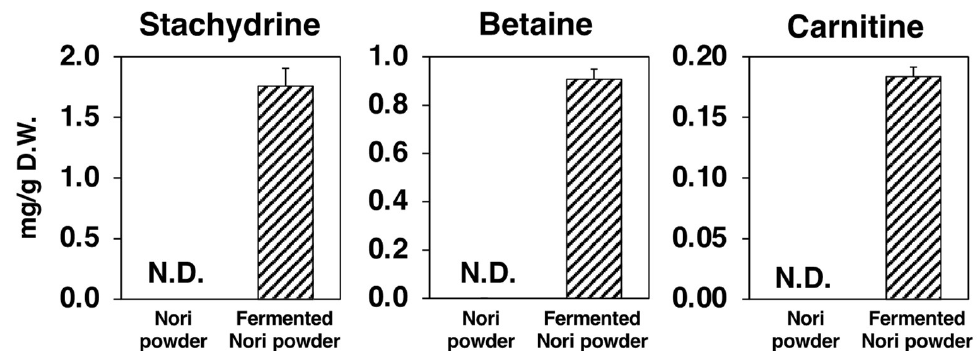
Figure 9. Amounts of representative metabolites of each group. Values are expressed as the mean ± standard error (n = 3). N.D.: not detected.